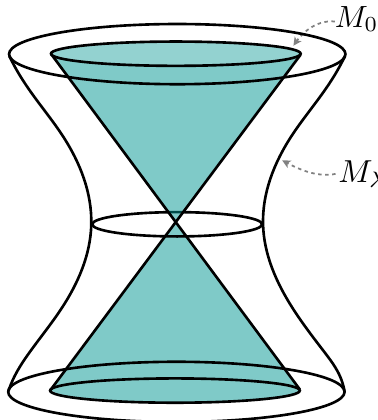
Figure 2 . The singular manifold described by f ( z ) = z 2 deformation (cid:21) in (4.1) is turned on, the resulting smooth manifold M (cid:21) features a (cid:12)nite one-cycle with size controlled by the deformation parameter (cid:21) .